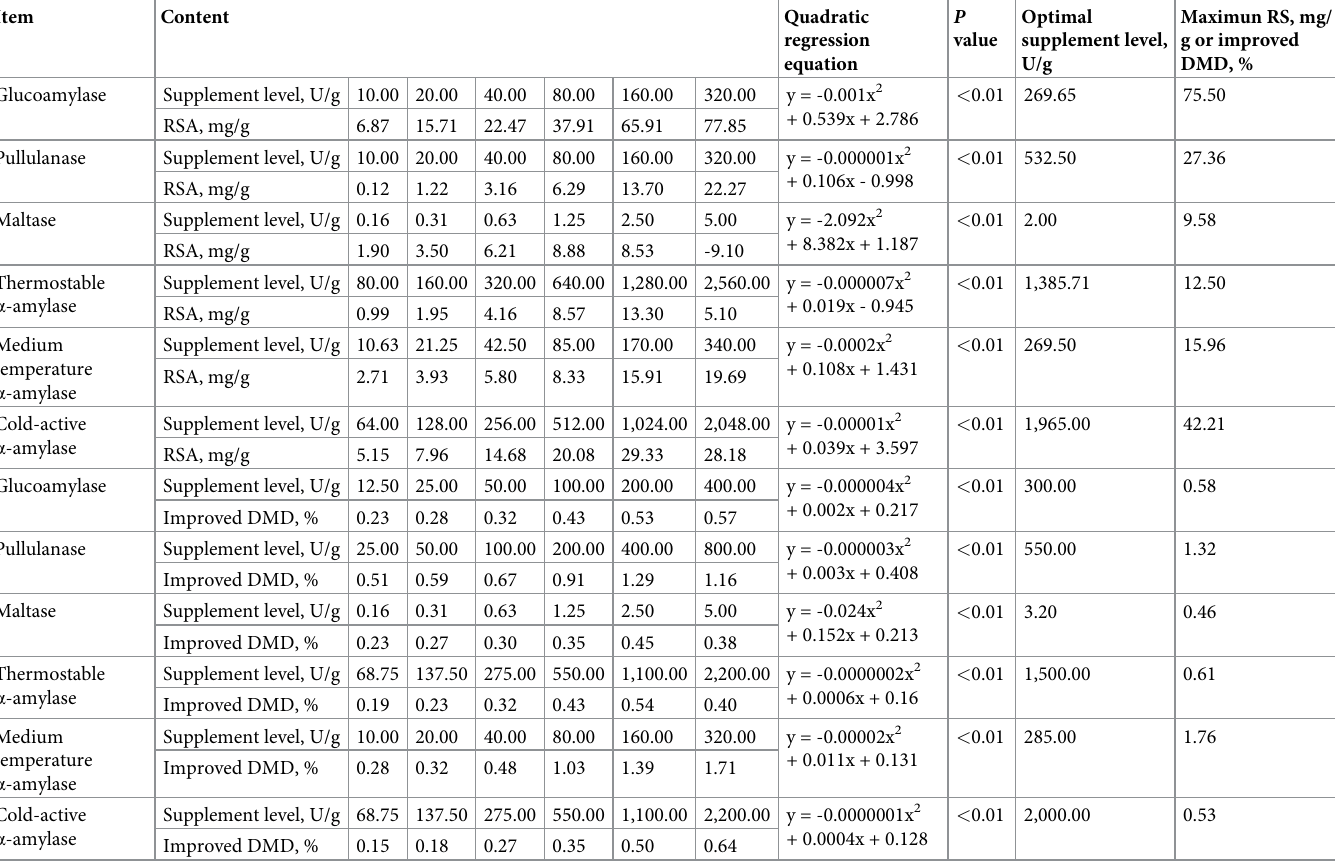
Table 4. Effects of supplementation of exogenous carbohydrase on the reducing sugar release rate and the improved dry matter digestibility of diets for broilers aged 1 to 3 wk.